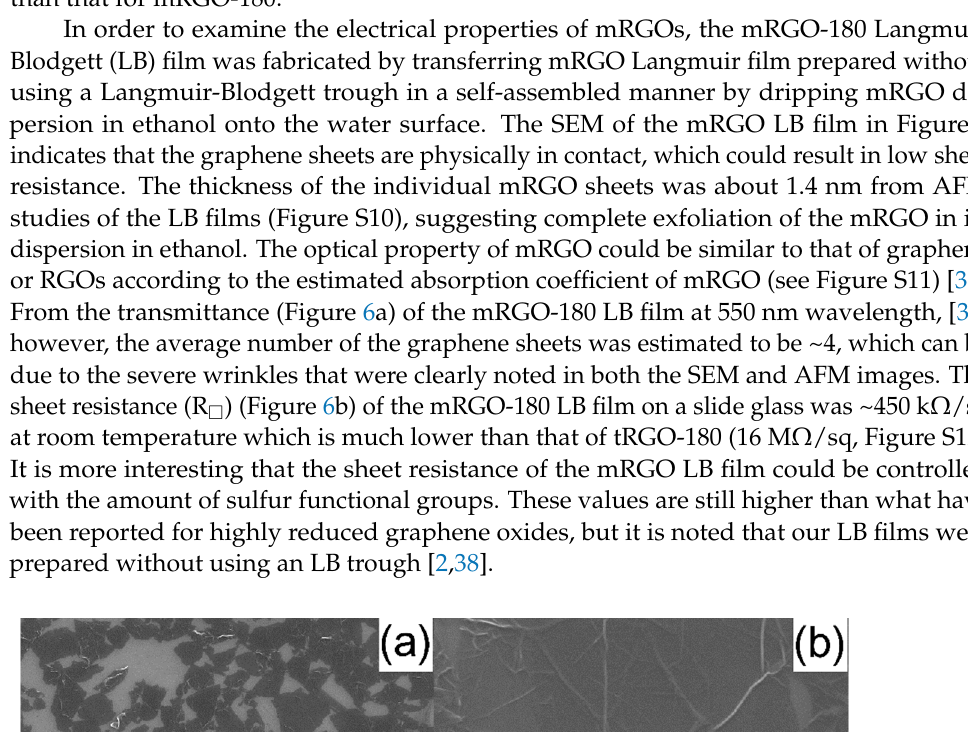
Figure 6. ( a ) Optical and ( b ) electrical properties of mRGO-180 LB film. Chemical functionalization of graphene creates atomic disorders and thus has a sig- nificant effect on the electron transport properties of the material. In order to elucidate the electron conduction mechanism for mRGOs, the relationship between R □ and temperature (T) was studied by using three different mechanisms: conventional hopping, Mott varia- ble range hopping (Mott-VRH), and Efros-Shklovskii variable range hopping (ES-VRH) models [39,40]. While the hopping model is described by an Arrhenius behavior of R □ , the VRH can be in general characterized in the Ohmic regime with a low bias voltage as R □ ( T ) = R 0 (cid:4666) (cid:3021) (cid:3116) (cid:3021) (cid:4667) (cid:3043) , where R 0 is a prefactor, T 0 is a characteristic temperature, and p is a characteristic exponent which is 1/3 for Mott-VRH [39] and 1/2 for ES-VRH [40]. Figure S13 shows the semi-loga- rithmic-scale plots of R □ vs. T –1 (conventional hopping), T –1/2 (ES-VRH), and T –1/3 (Mott- VRH) with extrapolating solid lines in both high temperature and low temperature re- gions. By comparing the linear extrapolating lines, it can be concluded that the electron transport in the sample follows the ES-VRH mechanism, while at high temperature it shows a Mott-VRH behavior. It has been recognized in the literature that such a crossover from ES- to Mott-VRH with increasing temperature takes place when the material has an intermediate degree of disorders [41]. In the ES-VRH region, it is possible to estimate the size of the so-called localization length ( ξ ) from the slope of the extrapolating line [41]: 𝑇 (cid:2868) (cid:3404)